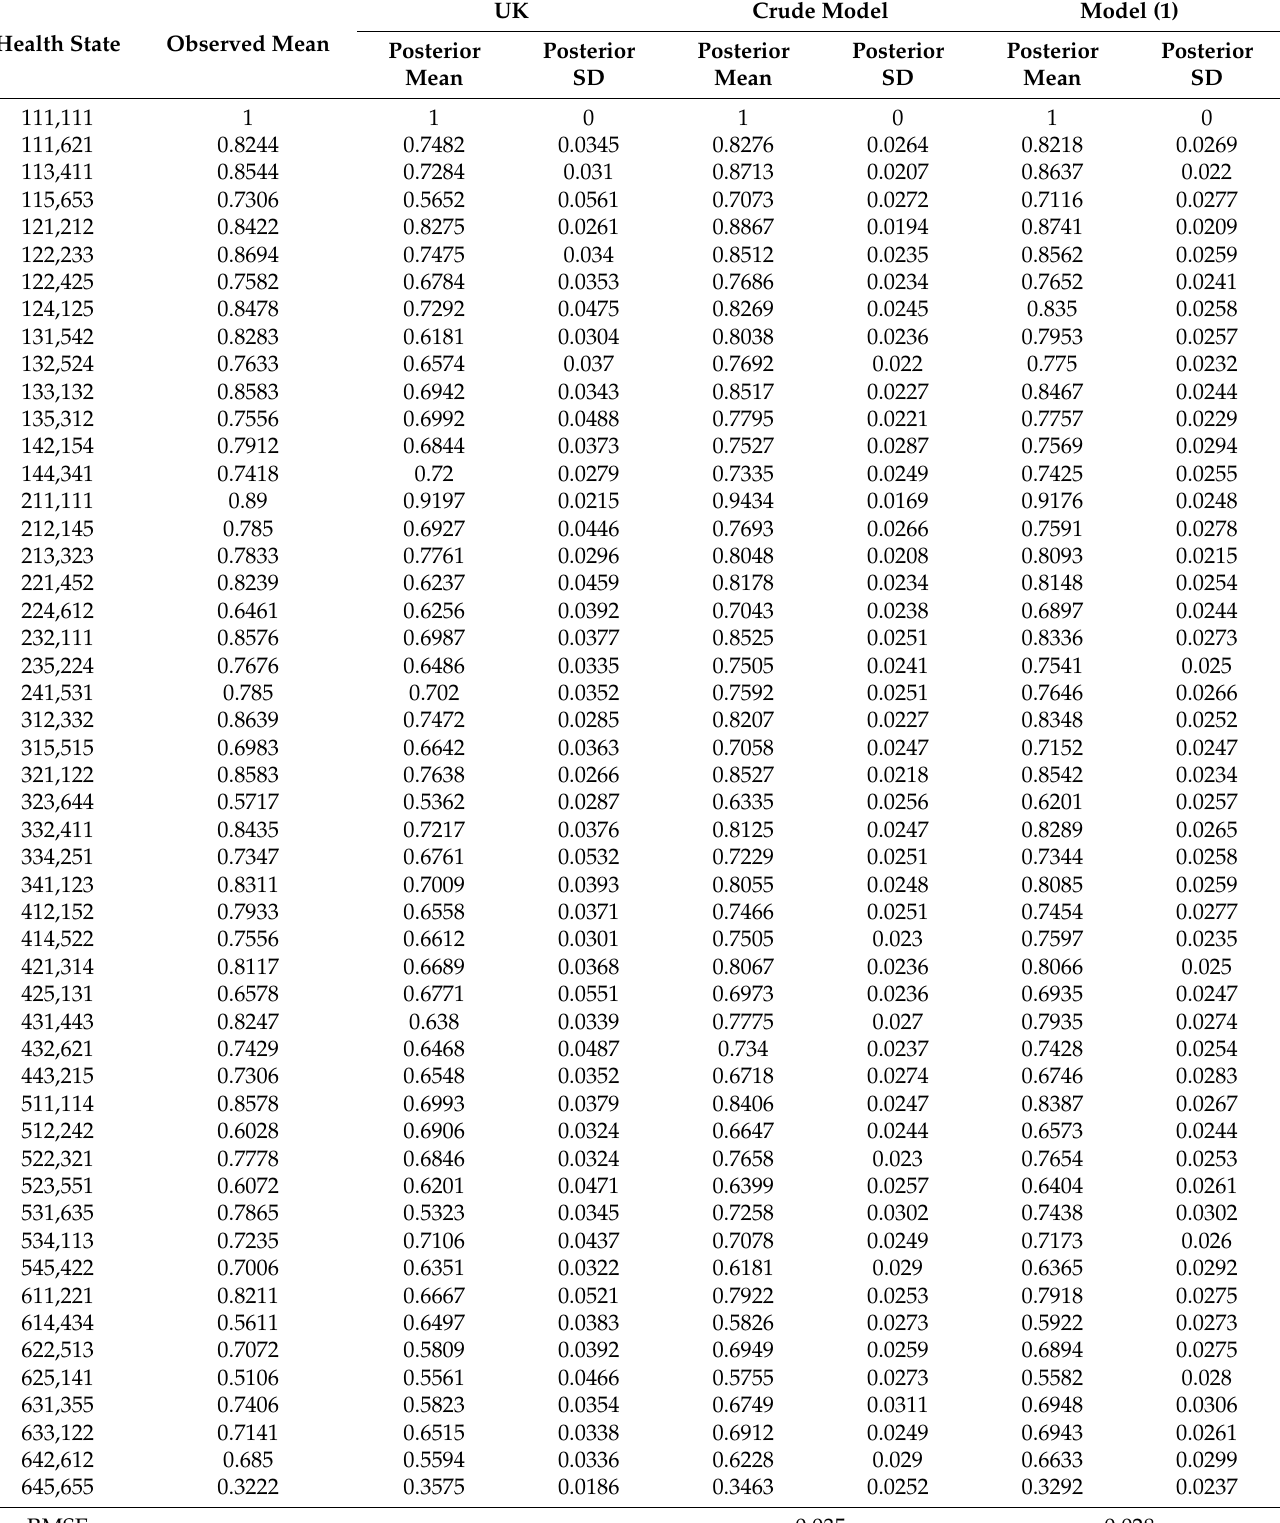
Table 1. Posterior estimates for the 49 health states in addition to full